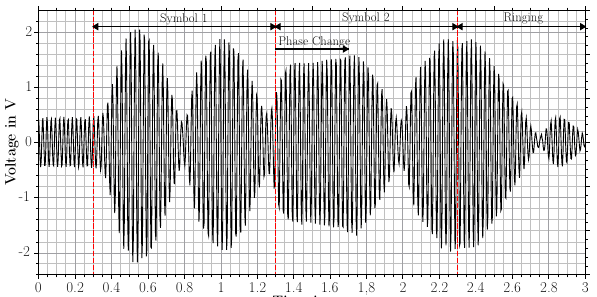
Figure 12. Measured voltage after the ADC of the receiver over time. The envelope changes with the difference frequency of 2kHz of the senders. Two symbols are transmitted with the phase change at the beginning of the second symbol.